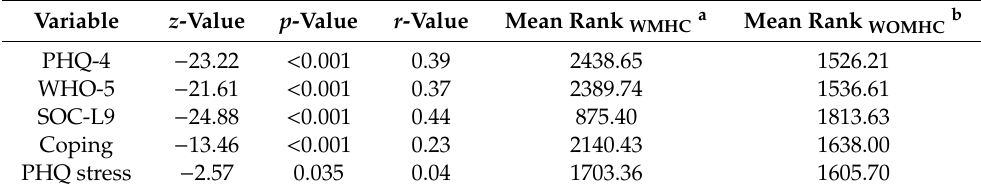
Table 2. Mann-Whitney-U-tests for group di ff erences between participants with (WMHC) and without (WOMHC) pre-existing mental health conditions.